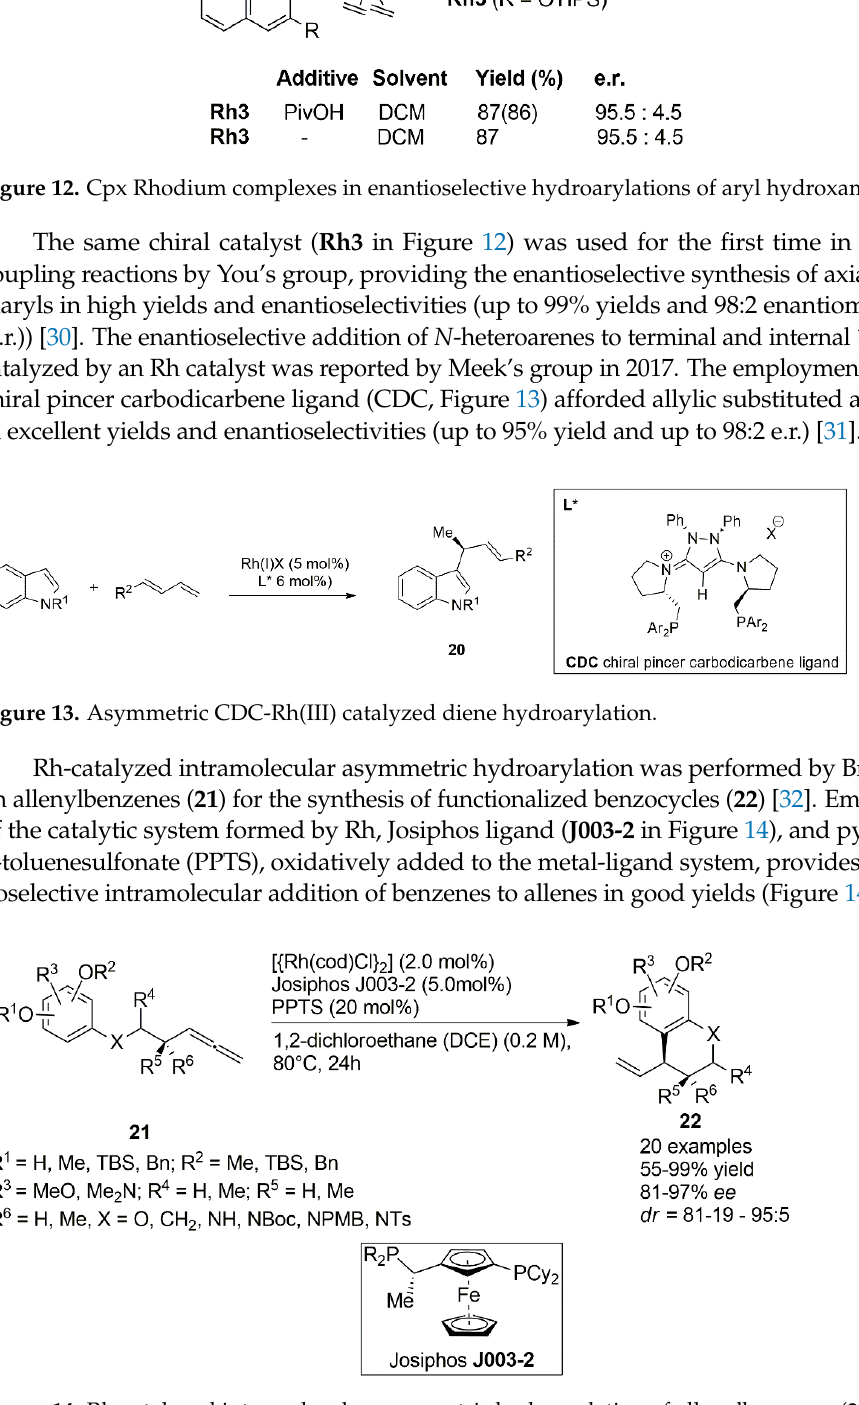
Figure 14 . Rh-catalyzed intramolecular asymmetric hydroarylation of allenylbenzenes ( 21 ).